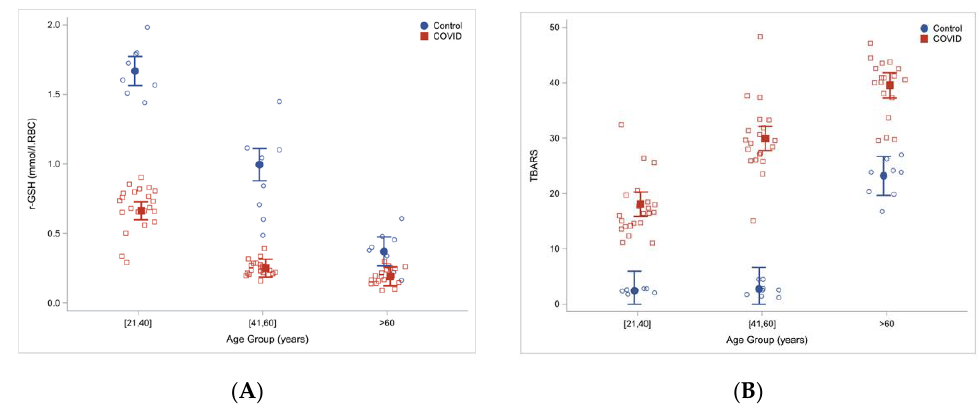
Figure 2. Reduced glutathione concentrations ( A ) and increased oxidative stress (TBARS) ( B ) in COVID-19 patients and uninfected controls stratified by age. Reproduced from ref. [28] with permission.